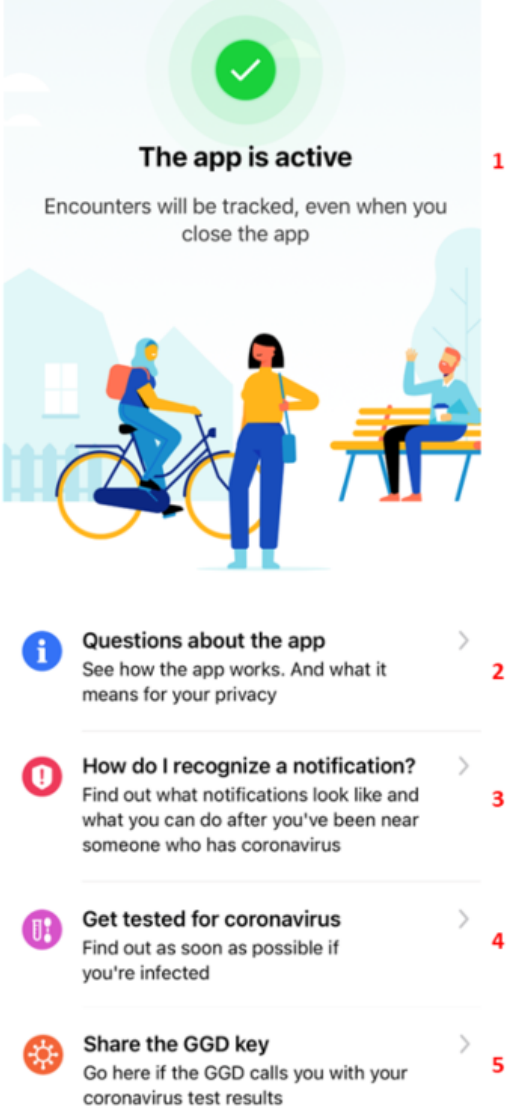
Figure 5. The app’s home screen, which appears after the user has finished the onboarding and activation of the app. At the top (1), the app explains its activation for use. Below this are several information pages on (2) how the app works (frequently asked questions), (3) what to do if one receives